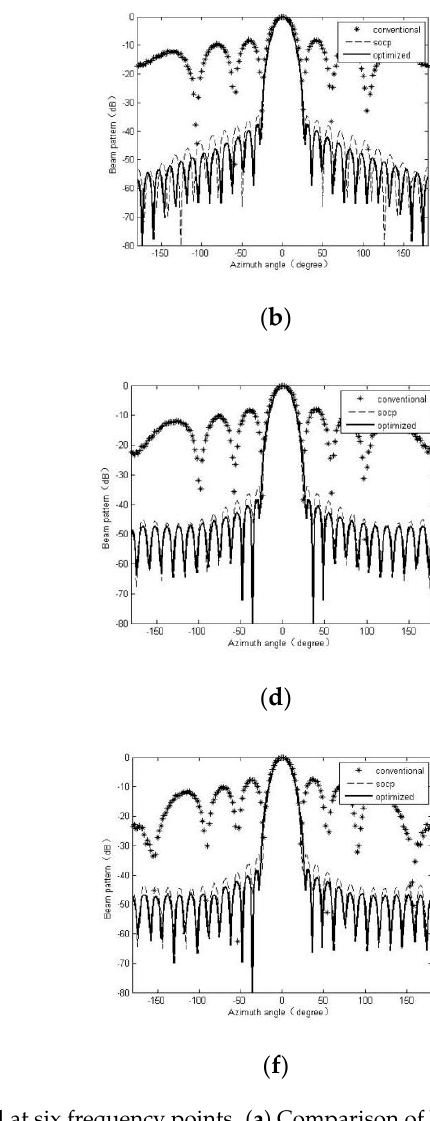
Table 4. Beam parameters of six frequency points for wideband signals.